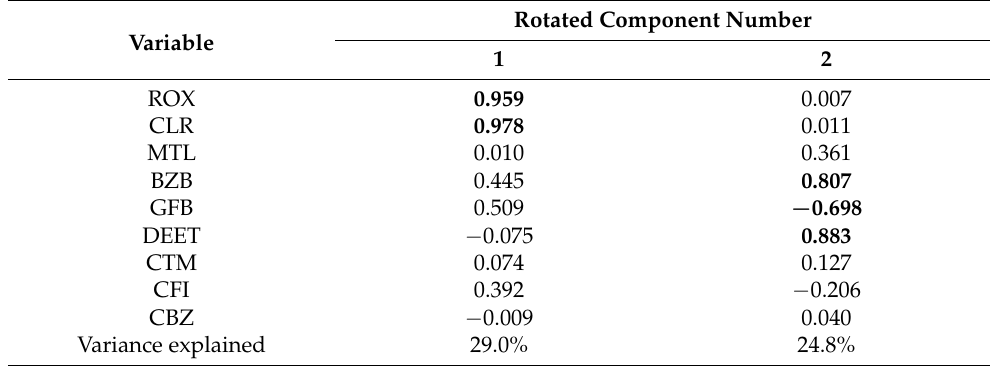
Table 4. Varimax-rotated component matrix following principal component analysis of all river water samples. Bold values denote the absolute value of PCA loading higher than